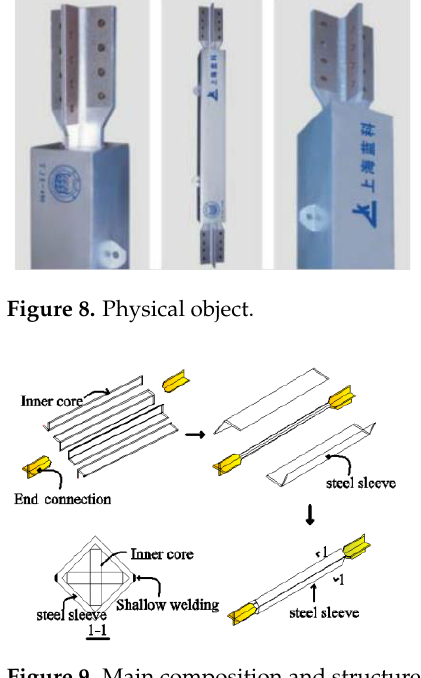
Figure 9. Main composition and